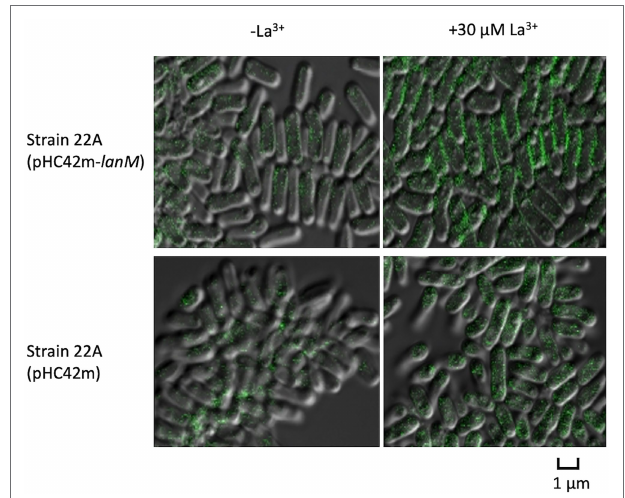
FIGURE 8 | Cellular localization of GFP-tagged LanM in strain 22A cells. Strain 22A wild type containing pHC42m- lanM and pHC42m was grown on methanol in the absence/presence of 30 μ M La 3+ for 3 days and observed with confocal fluorescence microscopy. Bar, 1 μ